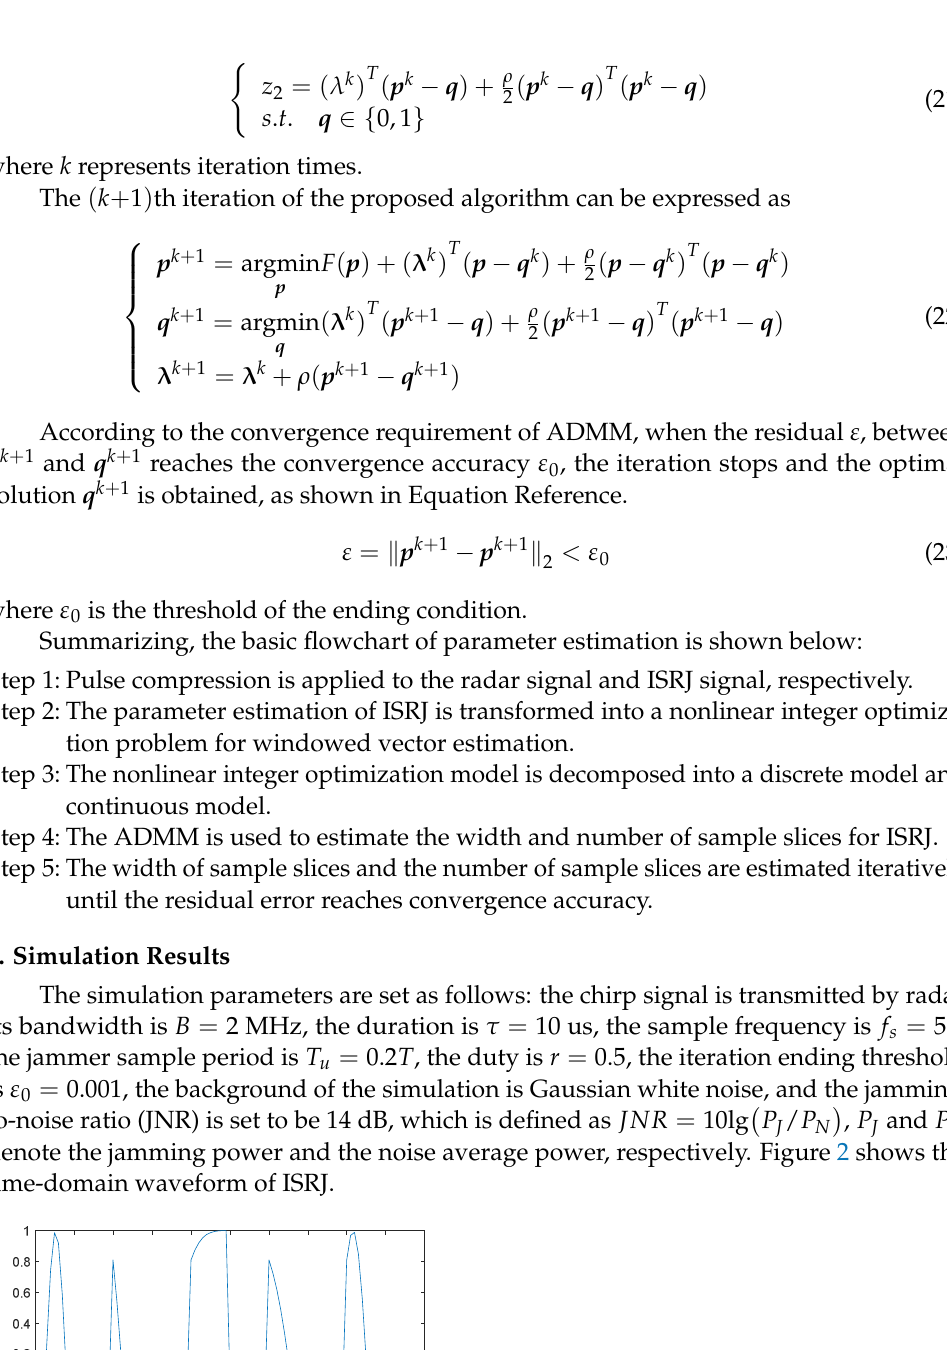
Figure 3. Residual convergence curve.